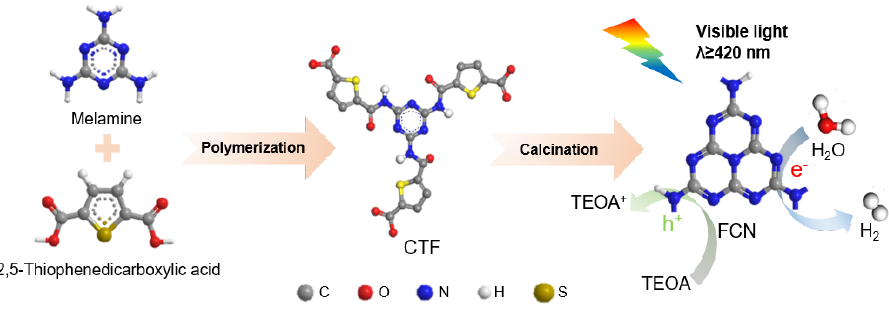
Figure 1. Schematic for the preparation of